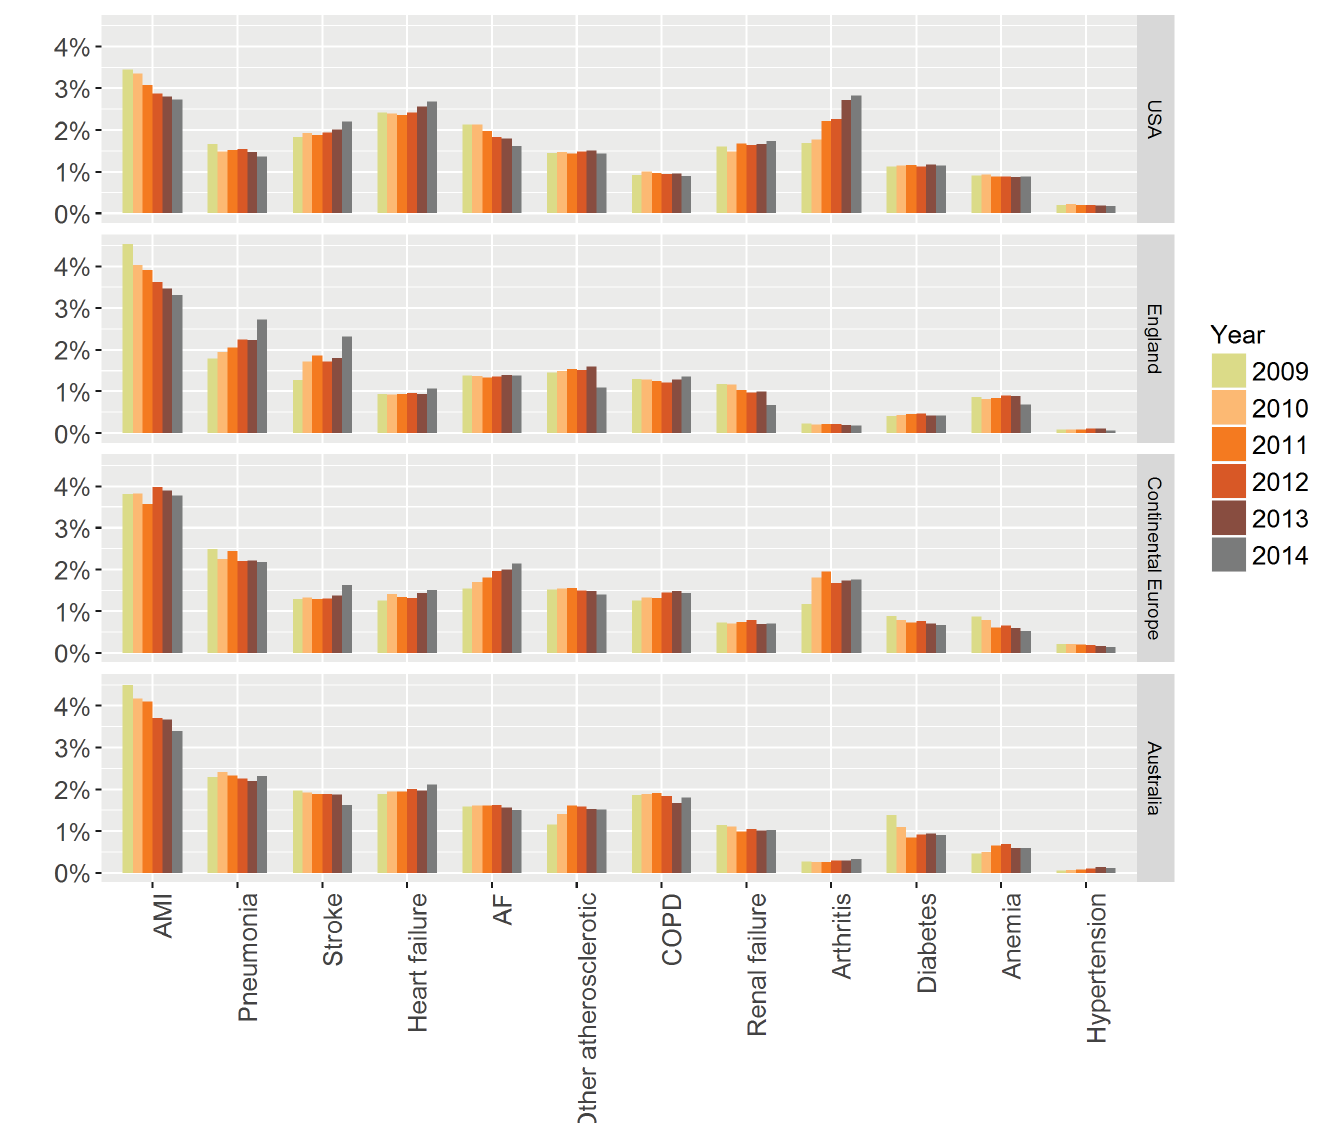
Fig 1. Proportion of admissions over time for the 12 chronic conditions in different countries. Abbreviations: AF atrial fibrillation; AMI acute myocardial infarction; COPD chronic obstructive pulmonary disease.